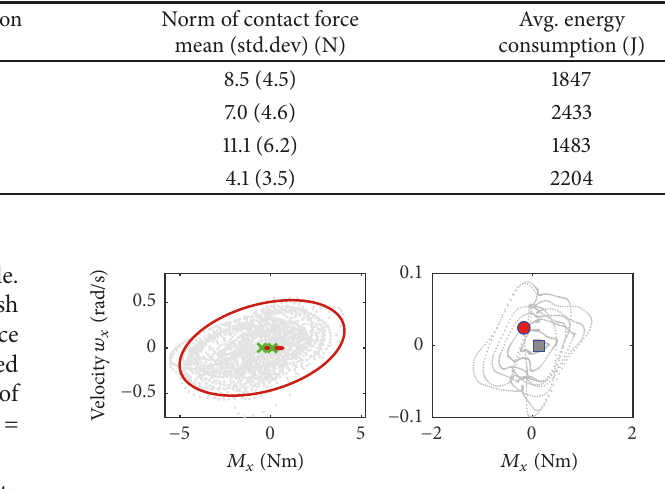
Figure 15: The GMM learning result and once peg-in-hole execu- tion. Left: GMM for {𝑀 𝑥 , 𝜔 𝑥 } in 𝑥 axis. The gray sample points are 20 groups of data of collaborative insertions for the peg 1 and hole 1. The red ellipse refers to the 3𝜎 confidence interval of GMM. Green crosses are the center points of GMM. Right: phase diagram for once auto execution with contact torque and angular velocity in 𝑥 axis, with the circle block for starting point and the square block for ending